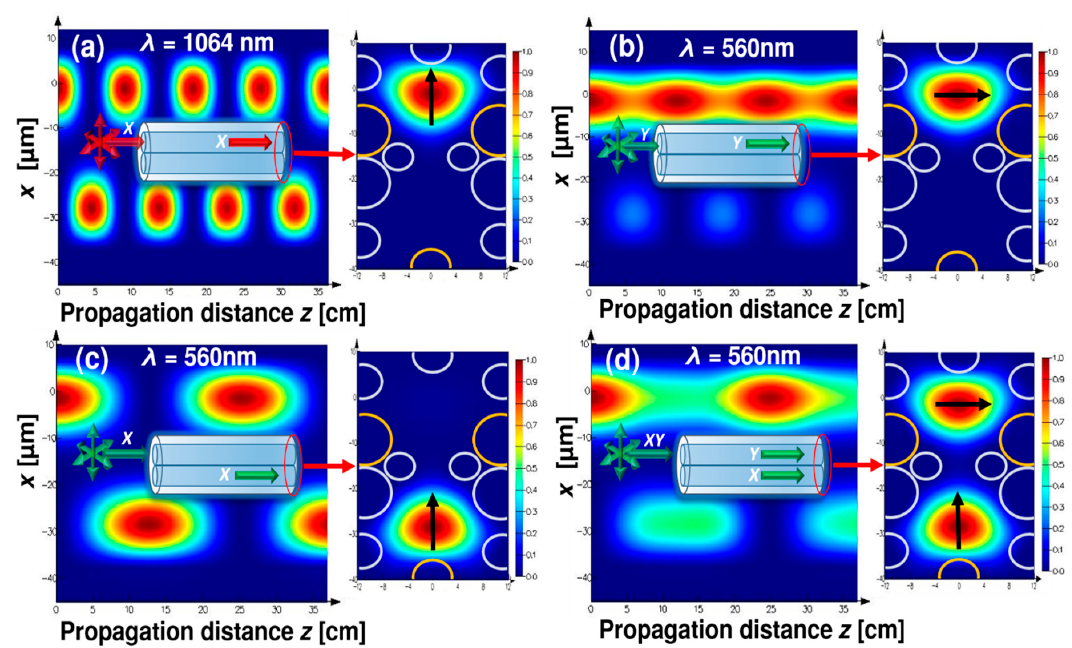
Figure 5. Distribution of the electric fields intensities during propagation along the DHC-ARF and at the output end of the DHC-ARF, for signals with di ff erent wavelengths and polarizations. Propagation of the ( a ) X -polarized excitation signal at 1064 nm, ( b ) Y -polarized fluorescence signal at 560 nm, ( c ) X -polarized fluorescence signal at 560 nm and ( d ) unpolarized fluorescence signal at 560 nm. Insets in ( a – d ) visualize the direction of propagation in the cores of DHCARF for a given situation; letters X - and Y - are related to the polarization direction. Red circles indicate the distal end of the DHC-ARF, where the output mode fields were calculated. Those fields are presented on the right of their corresponding propagation graphs, pointed out by the red arrows. The yellow and grey circles in the output mode field figures are the DHC-ARF’s capillaries, with di ff erent colors indicating capillaries with di ff erent thicknesses, as previously described in Figure 2a. Black arrows indicate the polarization direction of the output signal.